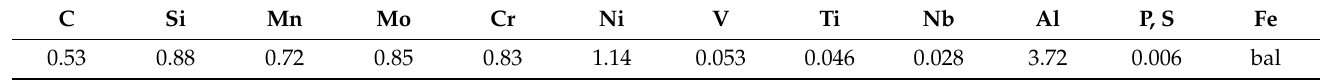
Table 1. Chemical composition of the experimental steel